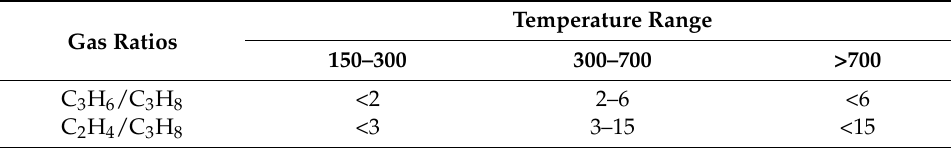
Table 8. Confirmation of the temperature range for the thermal faults.